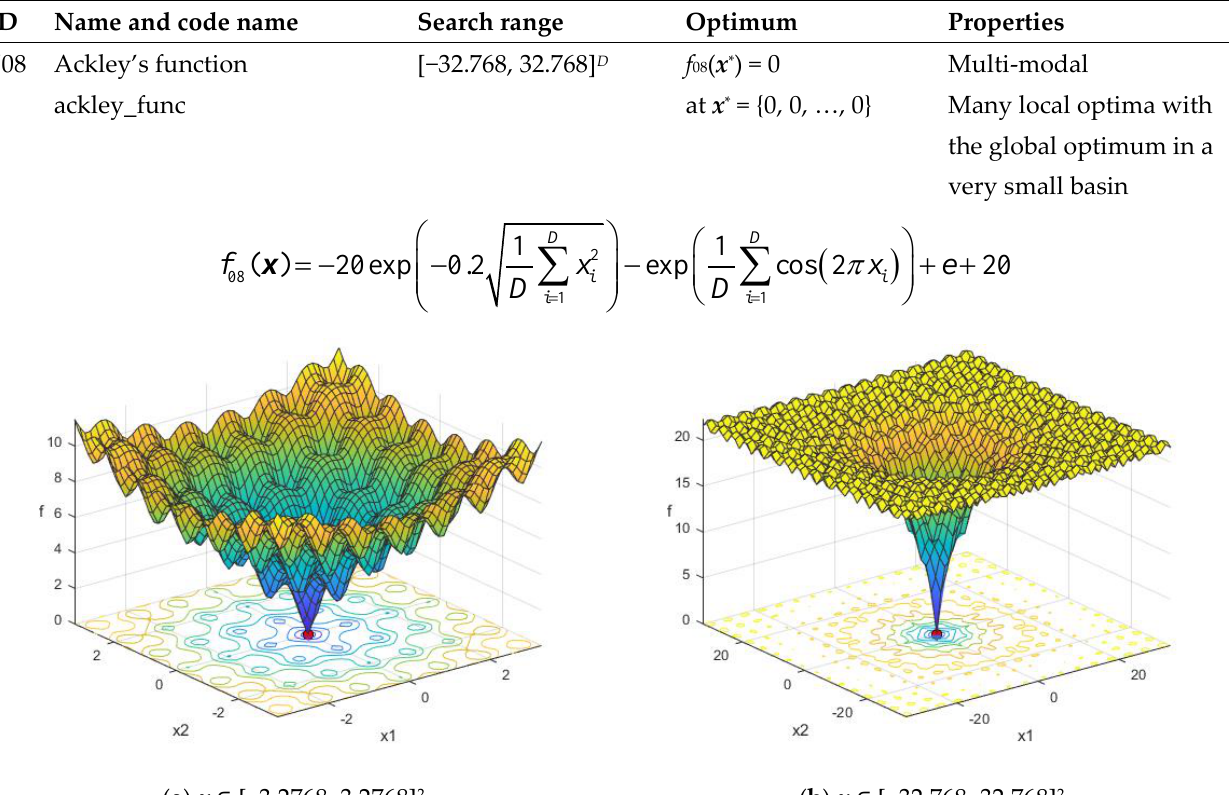
Figure A8. Ackley’s function in two dimensions.